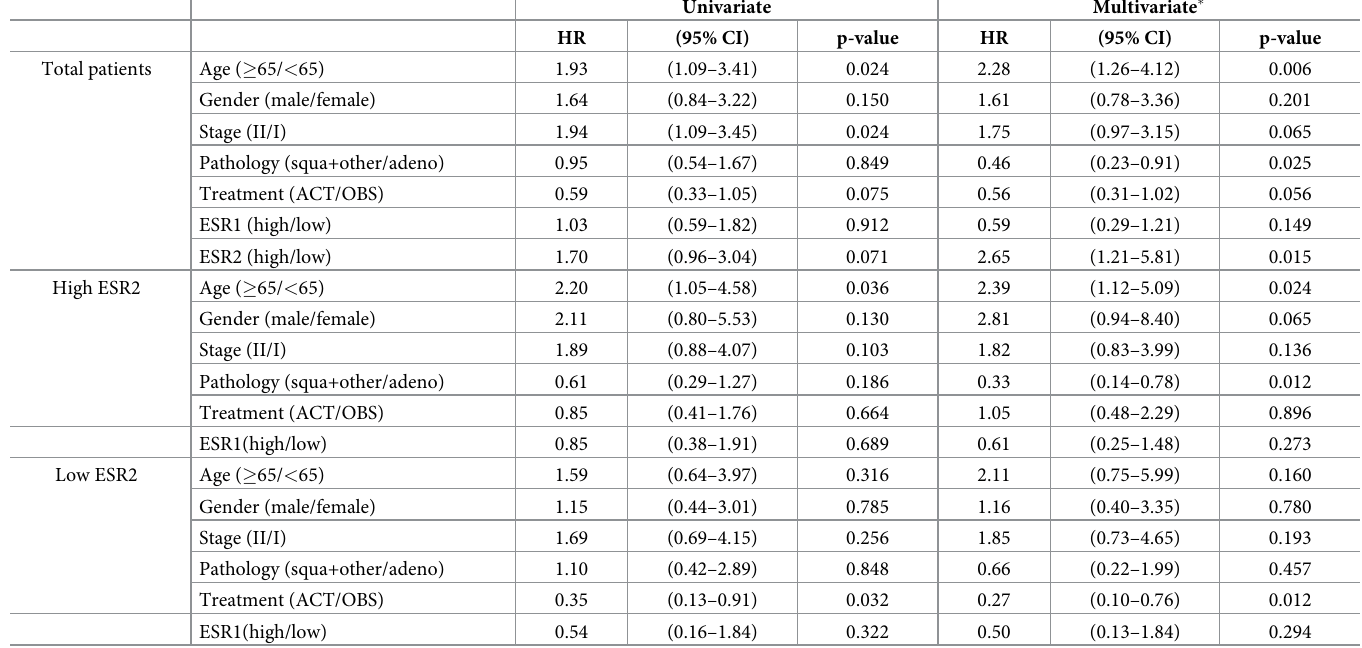
Table 3. Results of both univariate and multivariate cox regression analyses for total patients and subgroups with low and high ESR2 expression in the validation